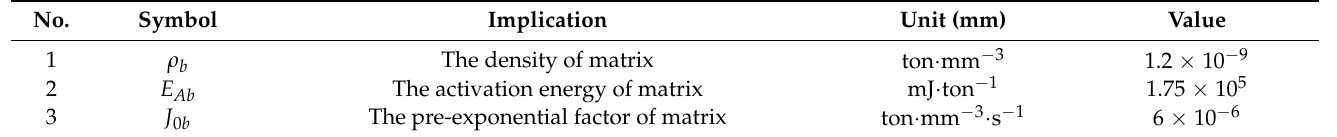
Table A1. The initial parameters in the coupled thermal-fluid-ablation